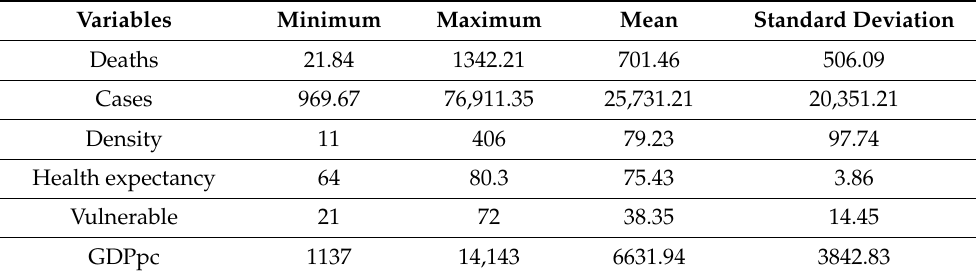
Table 1. Main Descriptive Measures.